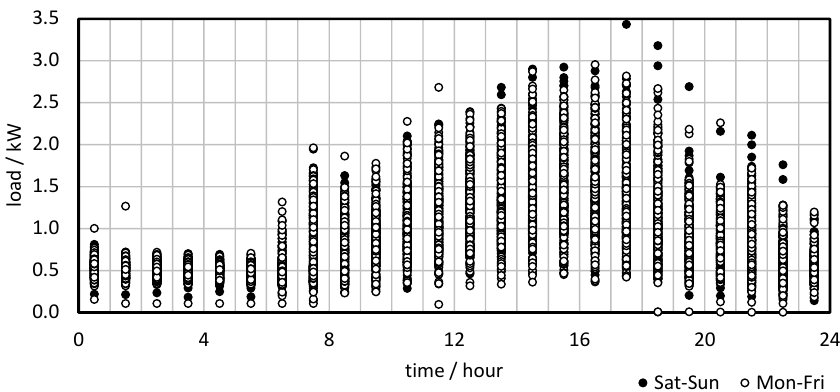
Figure 4. Daily variation in the measured load.